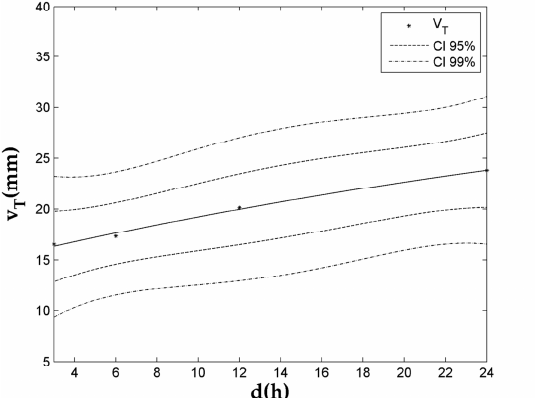
Fig. 5. Threshold values evaluated by Bayesian approach for the Mignone River basin: “real” case (solid line), “prone” case (dotted line) and “averse” case (dashed line) for the AMCIII soil condition (upper panel) and uncertainty associated with “real” case threshold (lower panel).